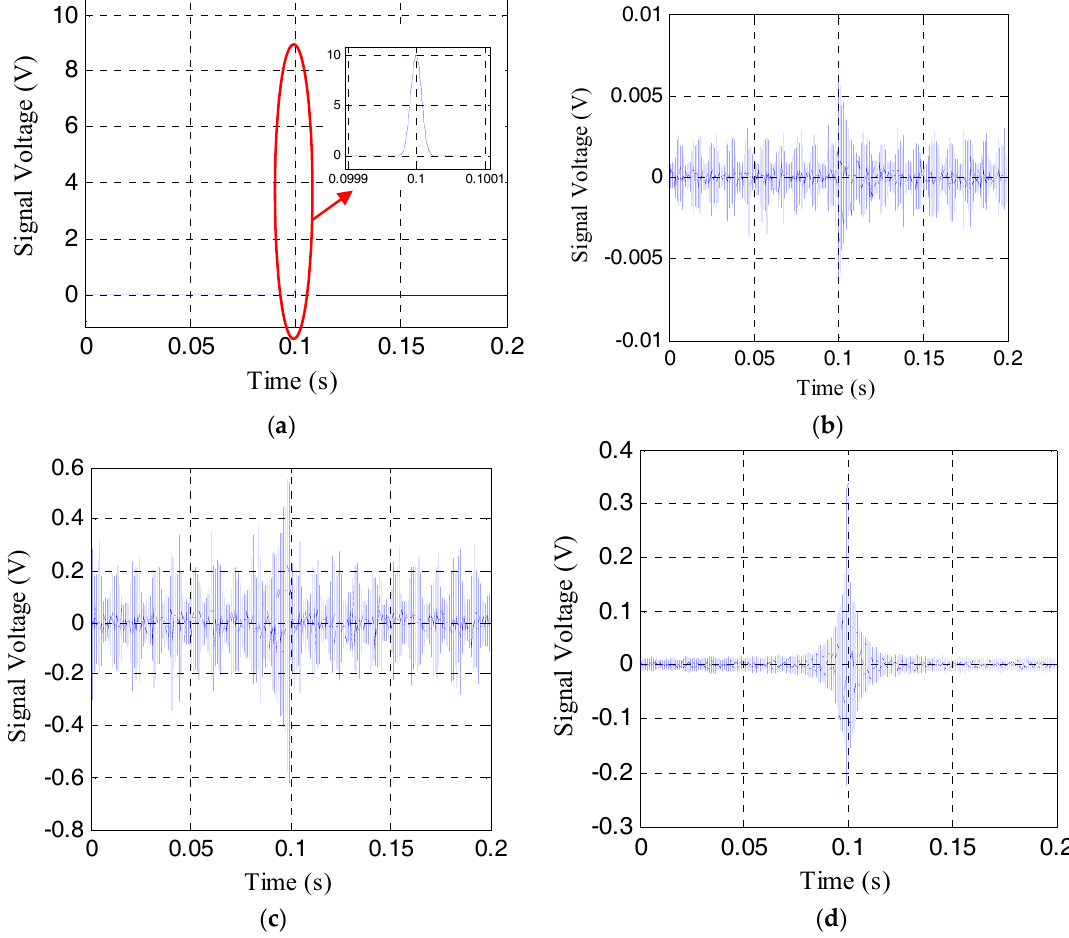
Figure 9. Four different signals in time reverse method at the pre-load of 1 MPa. ( a ) The emitted signal; ( b ) the received signal; ( c ) the reversed signal; ( d ) the focused signal.